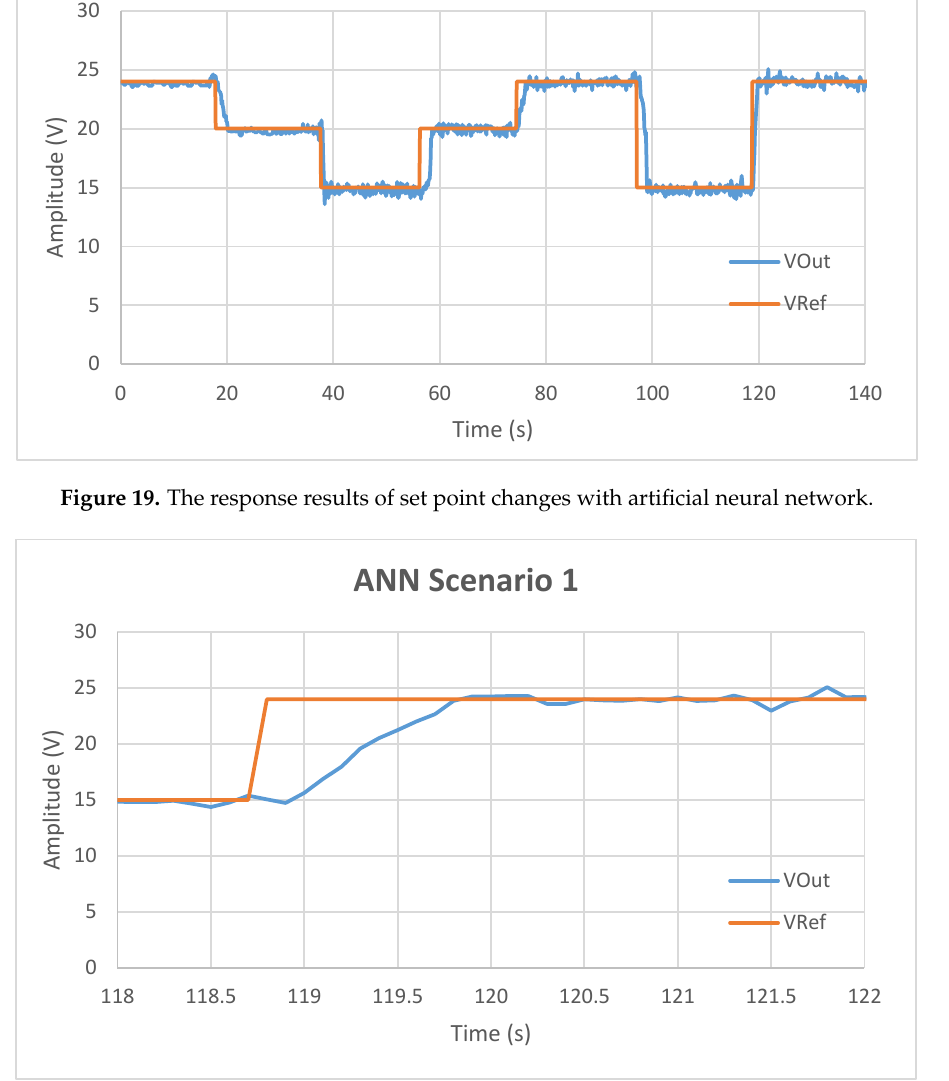
Figure 20. The response results of set point changes with artificial neural network controller on 118 to 122 s.